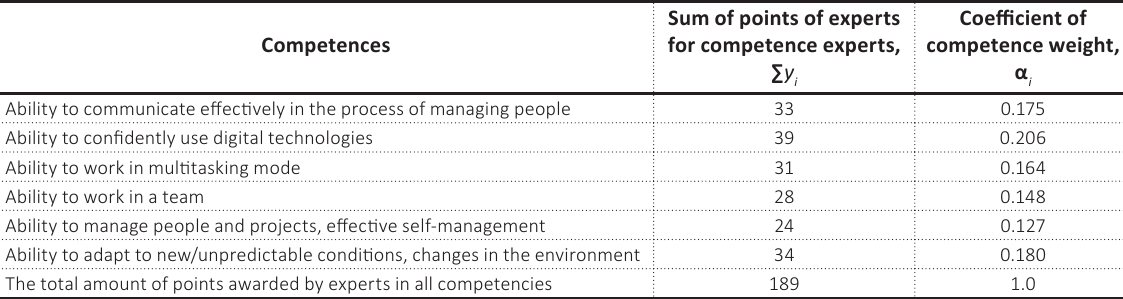
Source: Calculated by the authors based on the